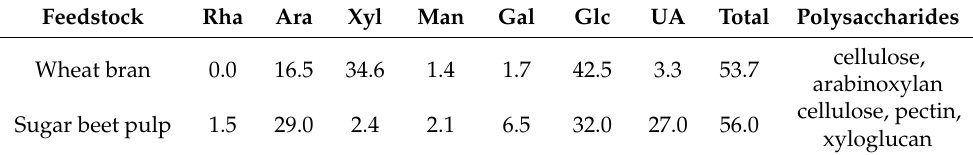
Table 2. Composition of wheat bran and sugar beet pulp (mol%) (Adapted from [36]). Feedstock